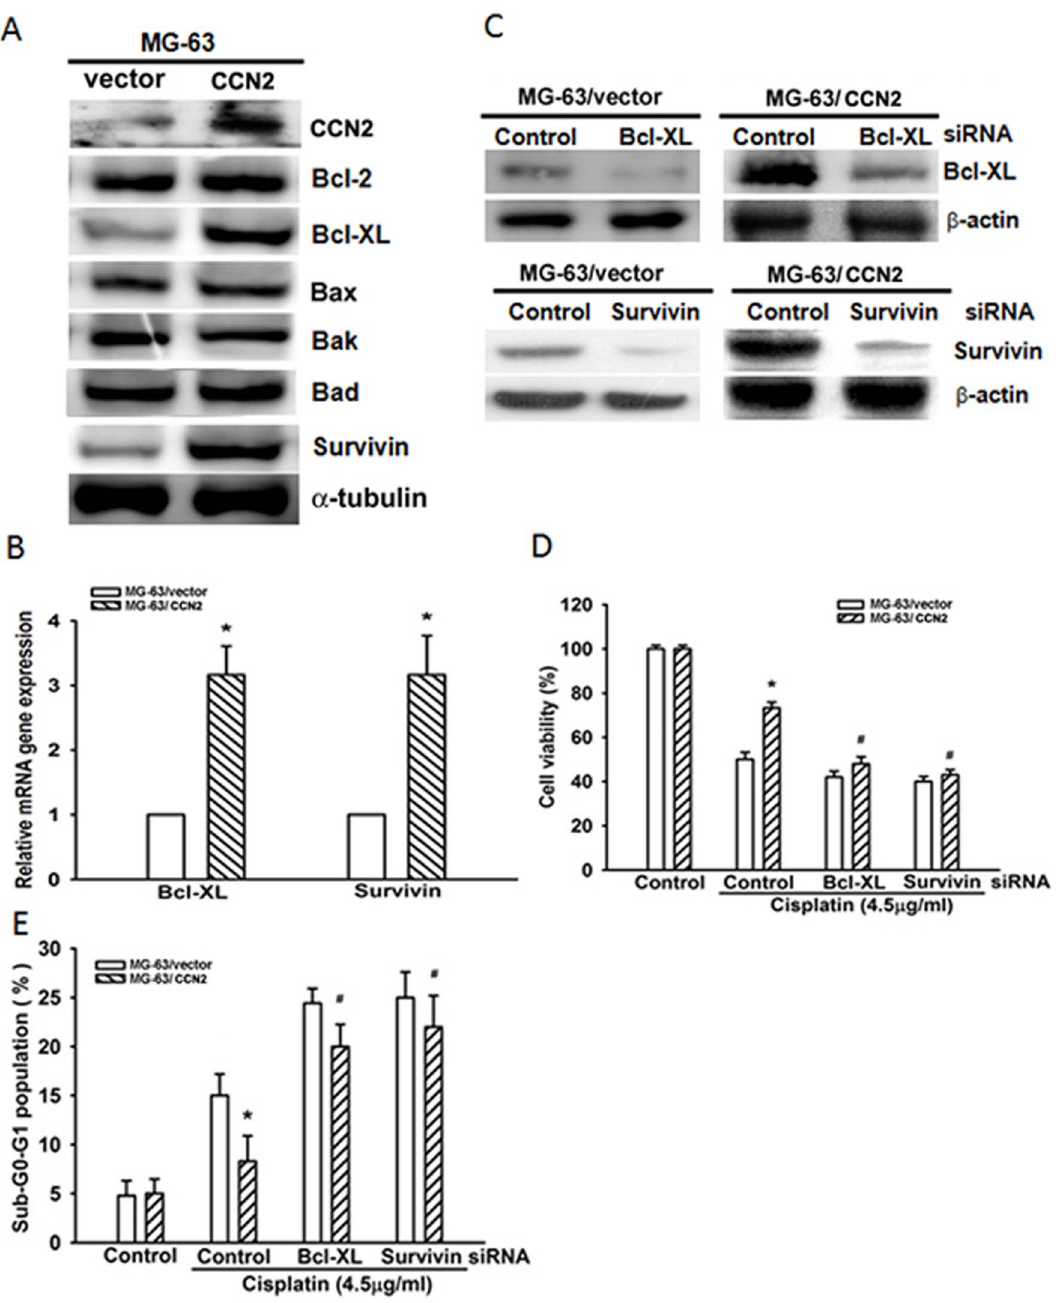
Figure 4. Bcl-xL and survivin are involved in CCN2-mediated chemoresistance. (A) Protein expression of the Bcl-2 family was examined by western blotting. (B) Cells were treated with cisplatin (4.5 m g/ml) for 24 h, and the mRNA expression of Bcl-xL and survivin was examined by qPCR. (C) Cells were transfected with control, Bcl-xL, or survivin siRNA, and the protein expression was examined by western blotting. (D & E) Cells were transfected with control, Bcl-xL, or survivin siRNA, and cell viability and apoptosis was analyzed by MTT assay and PI staining. Each experiment was done in triplicate. Results are expressed as mean 6 SEM. *, p , 0.05 as compared with MG-63/vector group; # P , 0.05 compared with MG-63/CCN2 cisplatin-treated control